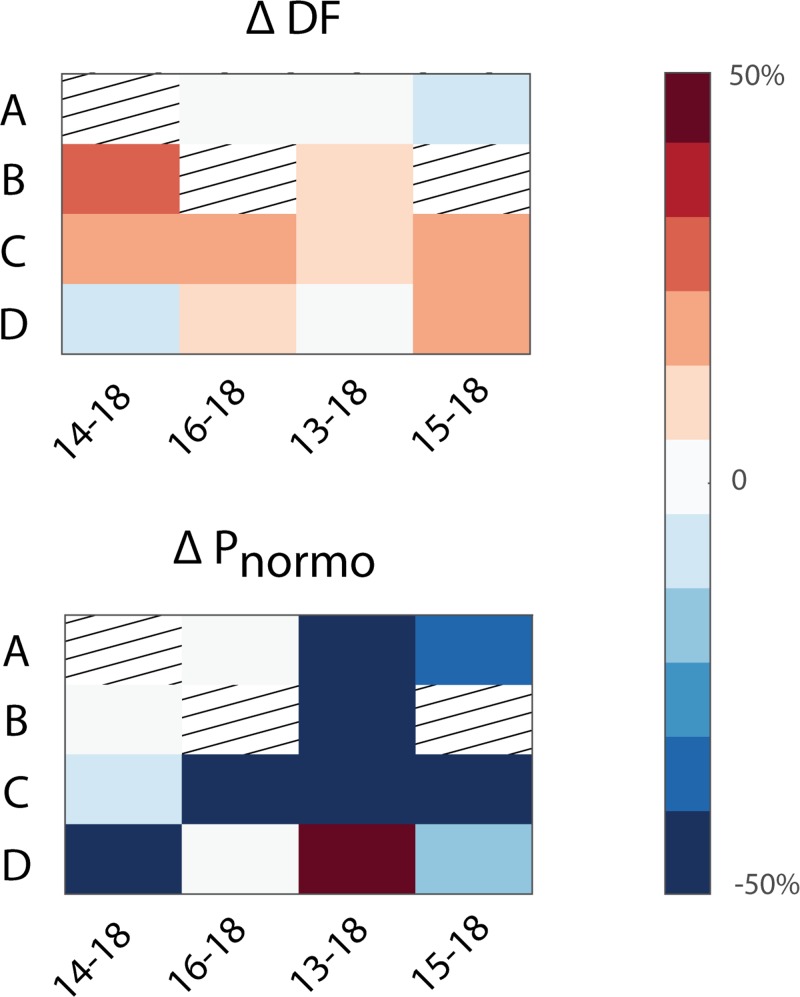
Change in DF and Pnorm after intra-gastric emetine.A) Heatmap of the change in DF and B) percentage of total power in the normogastric range after emetine infusion across subjects and gastric segments for animals 14–18, 16–18, 13–18 and 15–18. Grating represents gastric segments that did not display a DF at baseline or trials that were not administered.